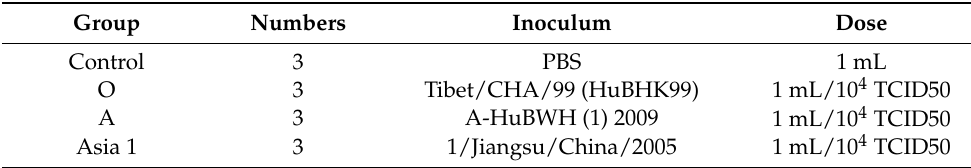
Table 2. The schedule for virus challenge of pigs according to